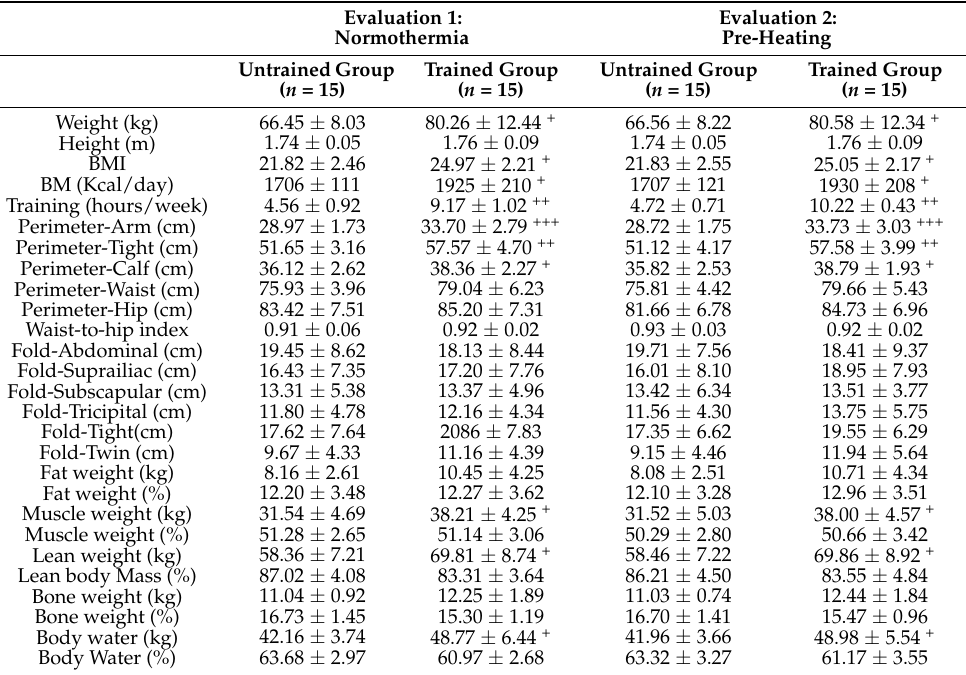
BMI: body mass index. BM: basal metabolism. Mann–Whitney U Test: differences between groups in each day: + p < 0.05; ++ p < 0.01; +++ p <